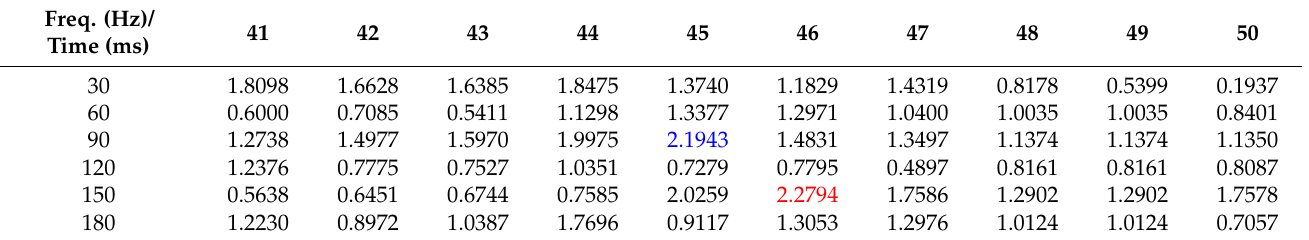
Table 7. The data of HS1 of class II, main frequency band 41–50 Hz, sampling time interval 30 ms. The maximum and second-highest energy ratios are highlighted in blue and red, respectively.